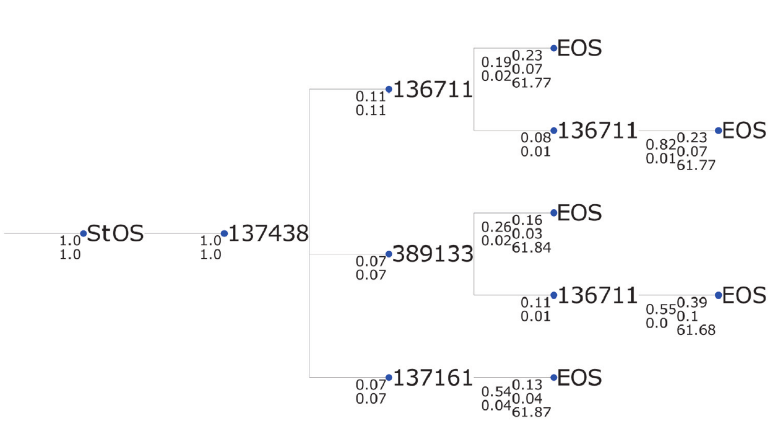
Figure 25: Output of the seq2probTree method for the HF production unit with input